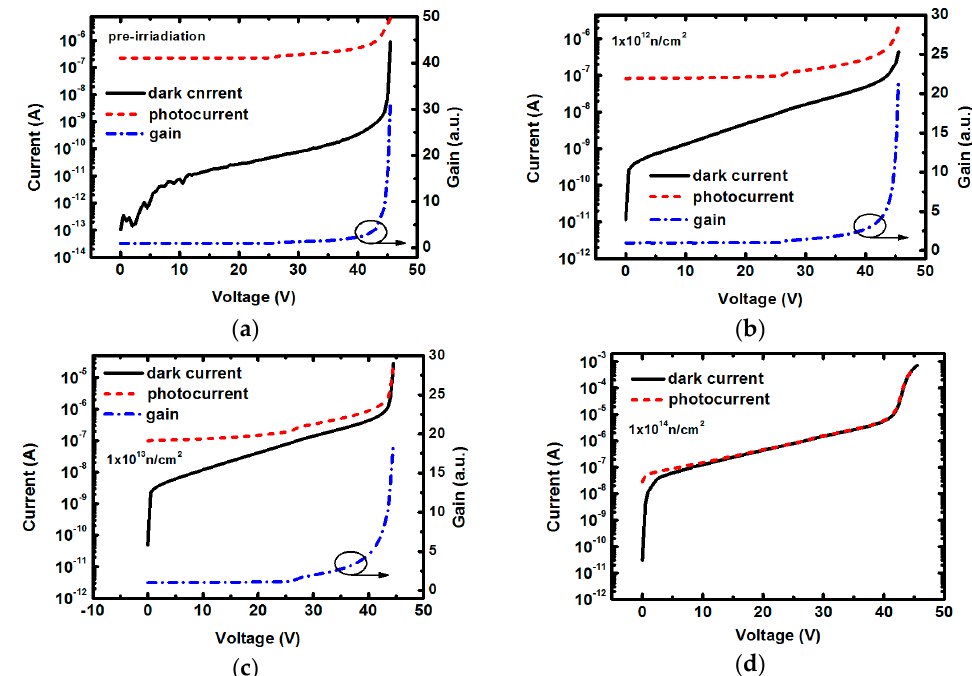
Figure 4. Reverse I-V characteristic of the InP-based APDs in dark and under illumination with incident light wavelength of 1550 nm. The right-hand axis indicates the gain. ( a ) pre-irradiation; ( b ), ( c ), ( d ) under neutron fluences of 1.0 × 10 12 cm − 2 , 1.0 × 10 13 cm − 2 , 1.0 × 10 14 cm − 2 , respectively.